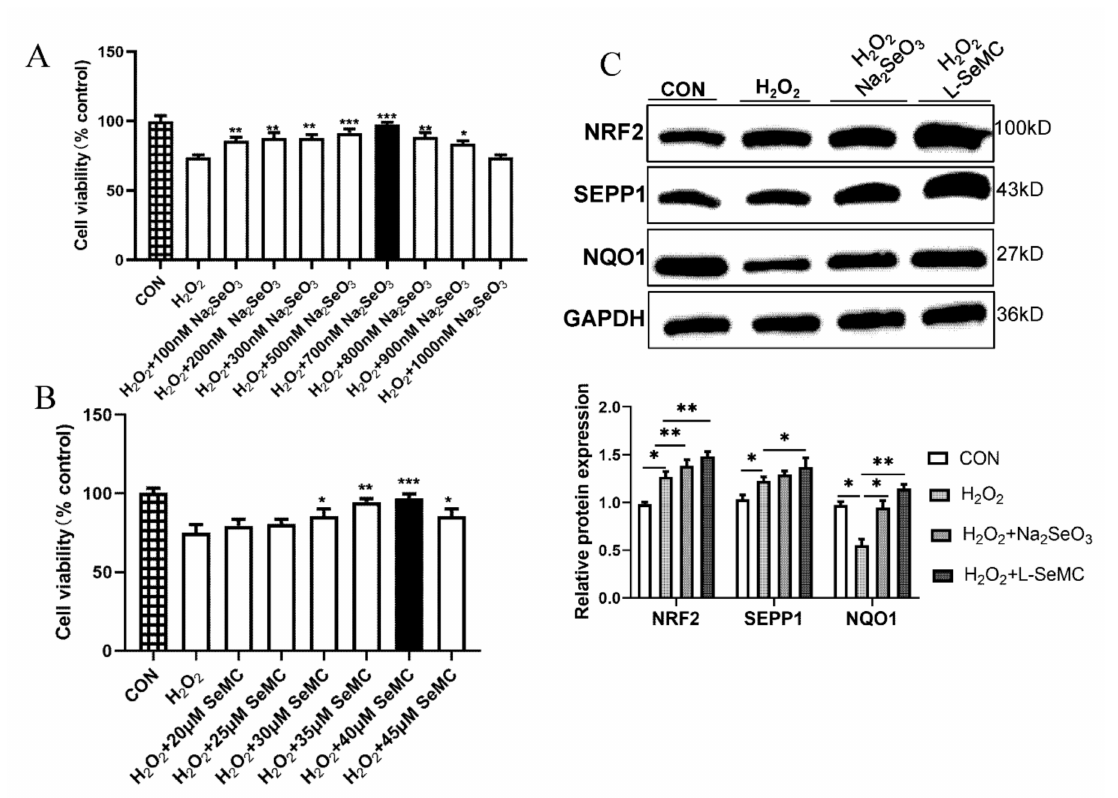
Figure 6. Effects of Na 2 SeO 3 and L-SeMC on oxidative stress in H 2 O 2 -induced AML-12 cells. ( A ) Cell viability of AML-12 cells was measured by CCK-8 after co-treatment with 100 µ M H 2 O 2 and different concentrations of Na 2 SeO 3 (0–1000 nM) for 3 h ( n = 7, *** p < 0.001, ** p < 0.01, * p < 0.05 vs. H 2 O 2 group). ( B ) Cell viability of AML-12 cells was measured by CCK-8 after co-treatment with 100 µ M H 2 O 2 and different concentrations of L-SeMC (0–45 µ M) for 3 h ( n = 7, *** p < 0.001, ** p < 0.01, * p < 0.05 vs. H 2 O 2 group). ( C ) The protein level of SEPP1, NRF2, and NQO1 ( n = 7, ** p < 0.01, * p <